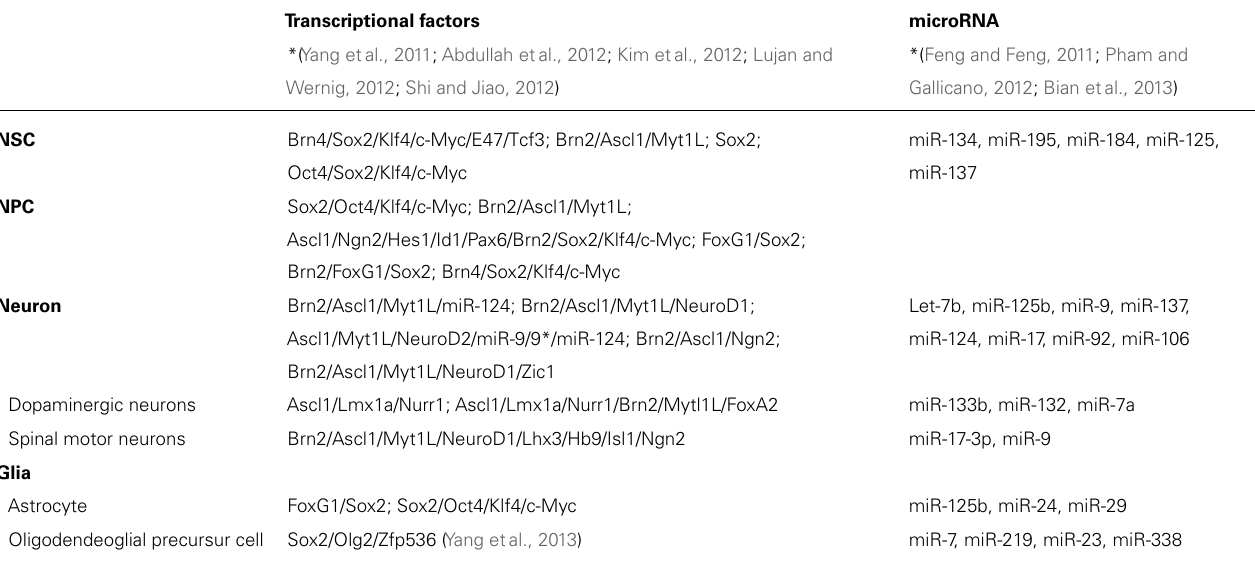
Table 2 | Suggested factors related to cell fate regulation for direct